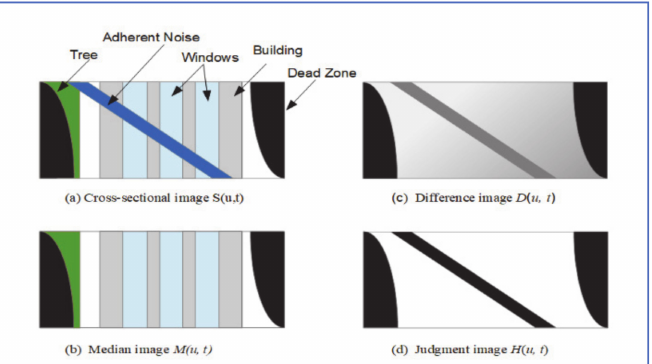
Figure 15. Different images generated in the Spatio-temporal rain detection approach